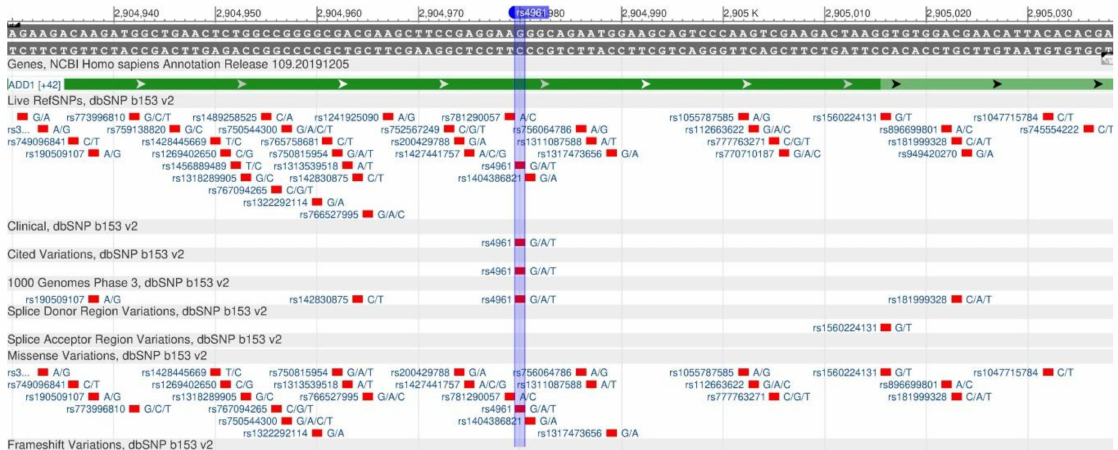
Figure 28. A portion of the ADD1 gene (located on the short (p) arm of chromosome 4) containing the oligonucleotide polymorphism rs4961.